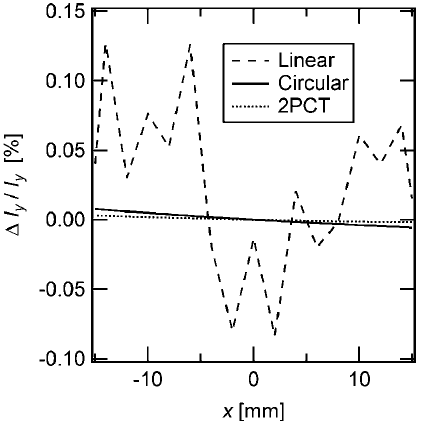
FIG. 12. Field integral computed from the multipoles and measured